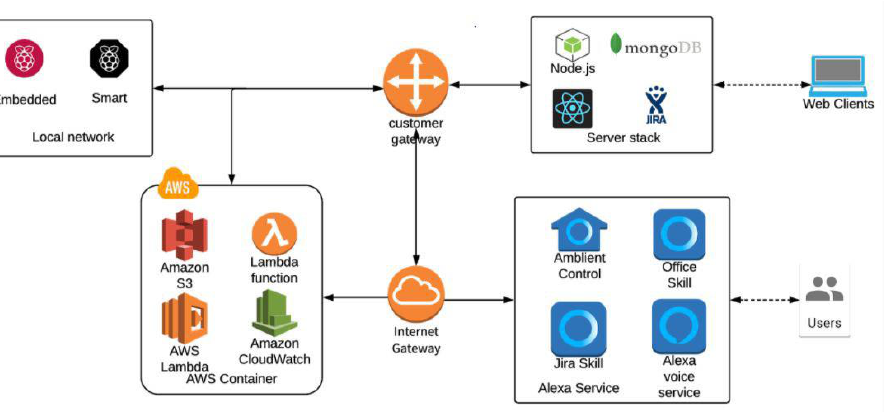
Figure 4. Software service architecture.